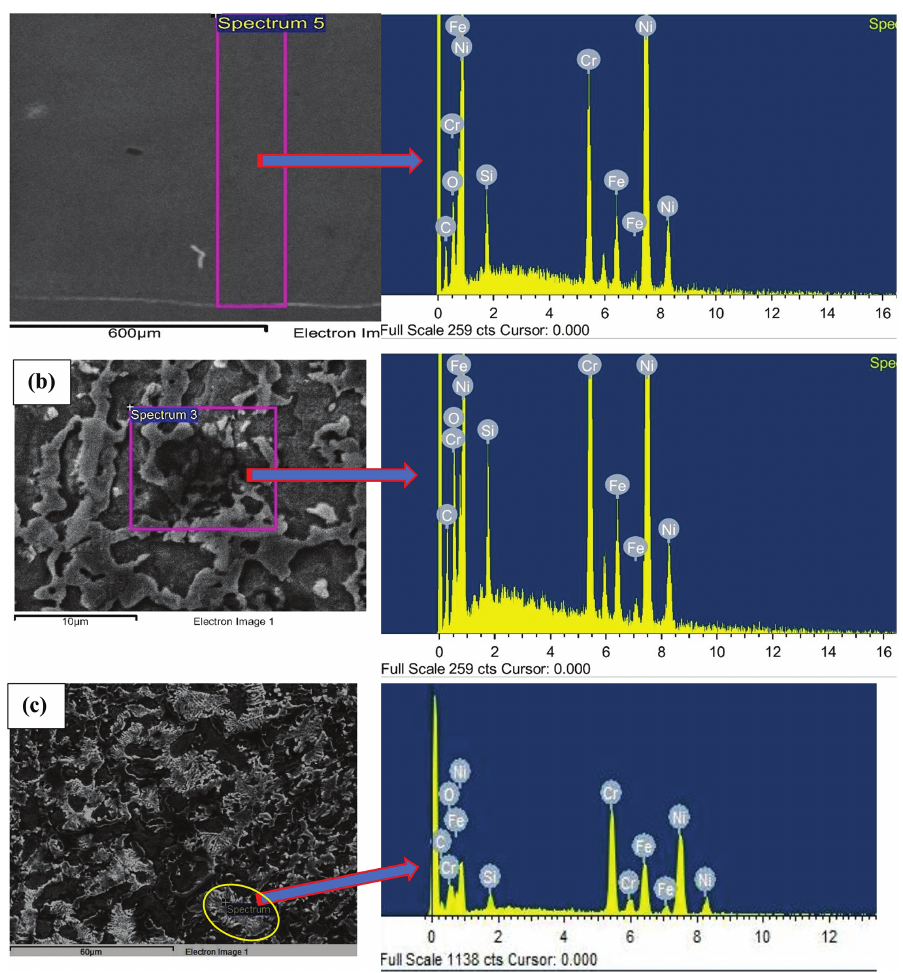
Figure 8: Scanning electron micrograph of the deposit and spot EDS.